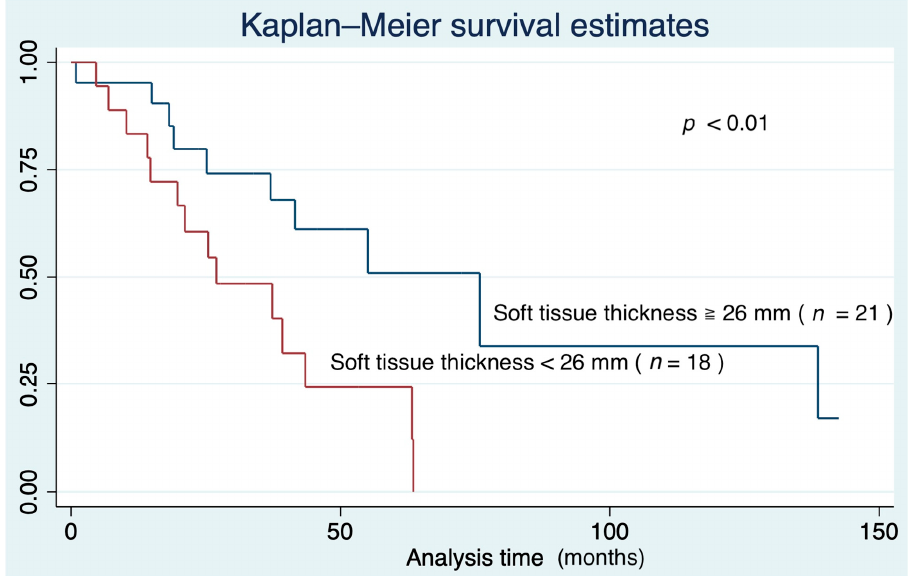
Figure 4. Kaplan–Meier survival curve based on soft tissue thickness.